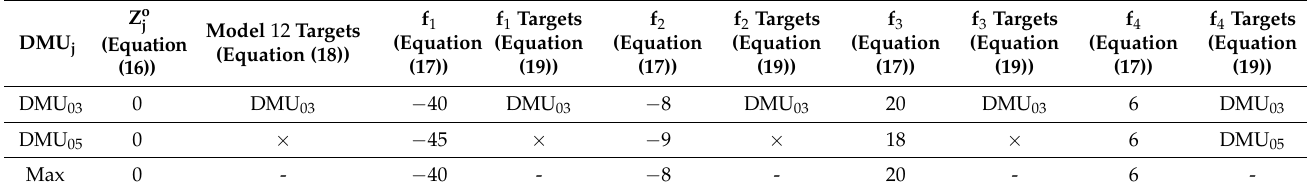
Table 10. Applying the second target finding stage for DMU05 (the first case